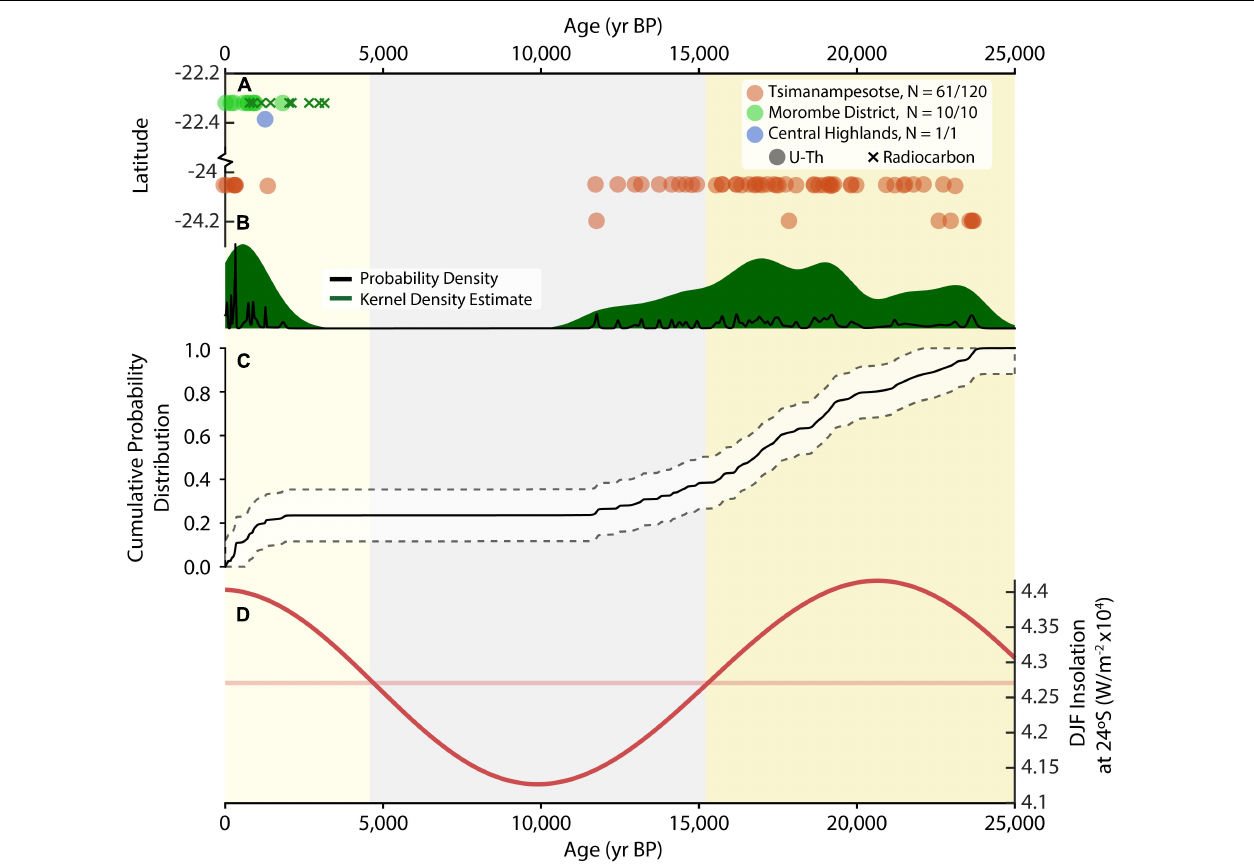
FIGURE 3 | Age distribution of stalagmites from southern Madagascar caves through time (see Figure 1 for map and Table 1 for full cave list). (A) Individual age determinations against latitude from caves within the TNP (red dots, based on 61 of 120 U-Th dated samples), Asafora Cave, Morombe District (green dots, based on all 10 U-Th dated samples, and green crosses based on 9 radiocarbon ages), and Andranomilitsy in the southernmost part of the Central Plateau, near Isalo (blue dot, based on a single U-Th dated sample). (B) Probability density function of age distributions (black line) and kernel density estimate (green shading). (C) Cumulative probability distribution of U-Th age distributions with error. The fluctuating gradient highlights relative periods of excess and deficient speleothem growth relative to the idealized smooth exponential distribution of stalagmite age distributions with time (Scroxton et al., 2016). (D) Integrated summer (DJF) insolation at 24 ◦ S (bold red line), and mean value (pale red line). Vertical color bars indicate periods with higher than mean insolation (yellows), and lower than mean insolation